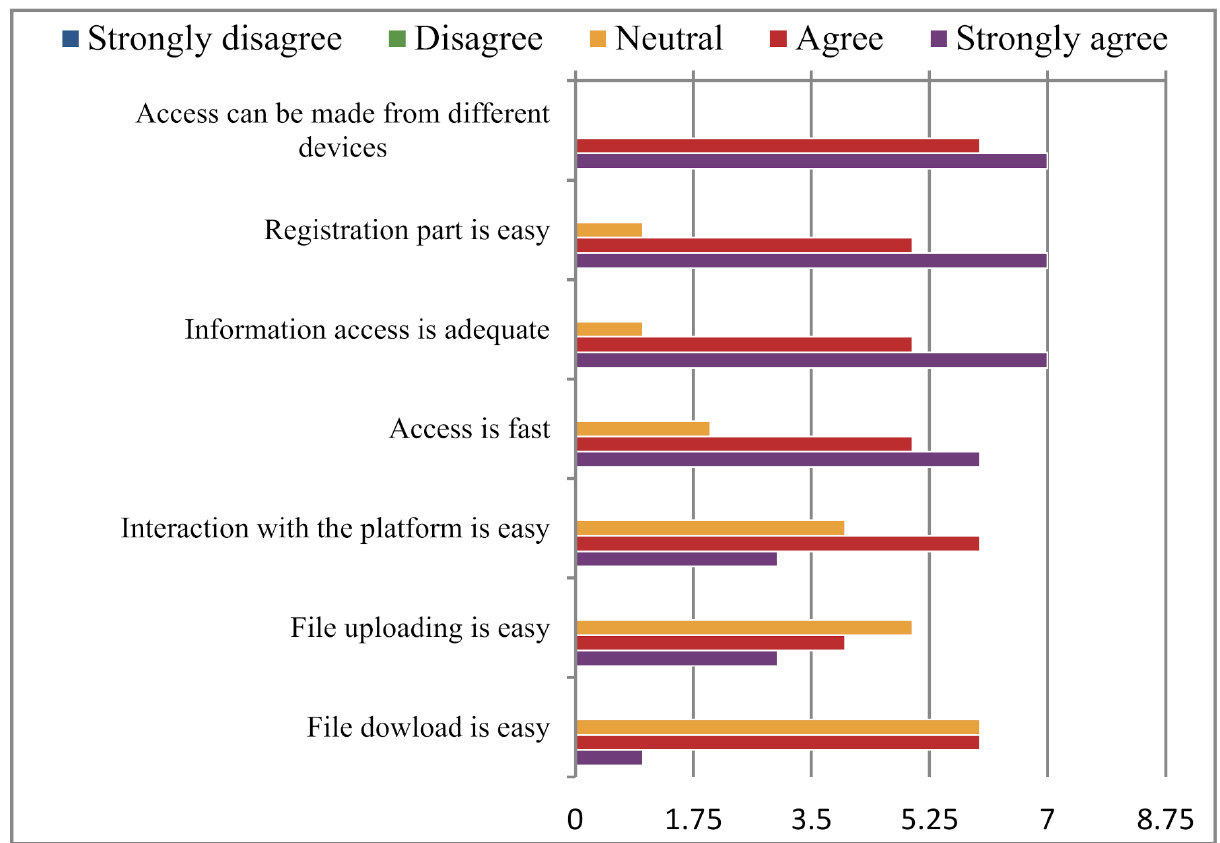
Figure 3. Evaluation phase 2. Technical aspects